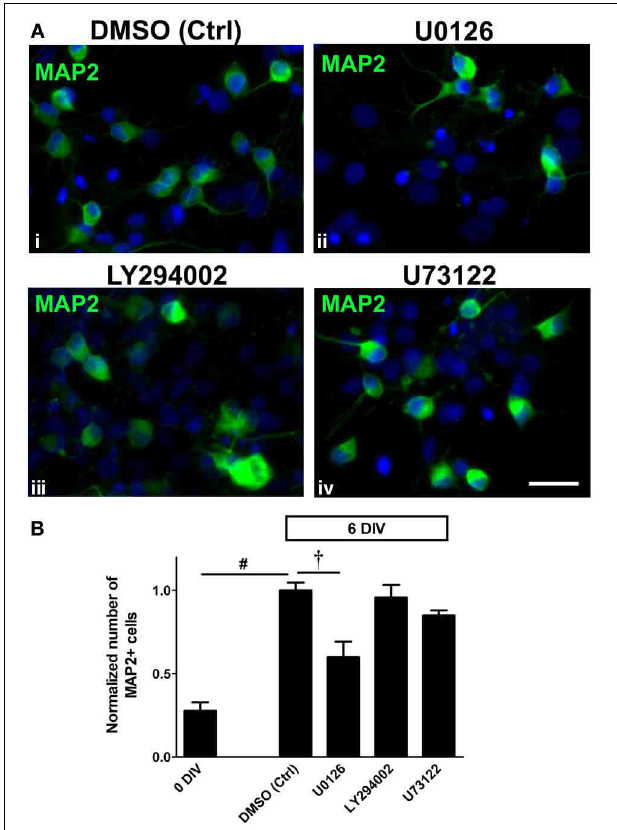
FIGURE 4 | Neuronal differentiation in adult spinal cord NSPC cultures is ERK1/2-dependent. (A) Immunostaining for MAP2 in adult spinal cord NSPC cultures after 6DIV in vehicle control (DMSO) (i), U0126 (10 μ M) (ii), LY294002 (10 μ M) (iii), and U73122 (2.5 μ M) (iv). Compared to the vehicle control (i), the number of MAP2 + cells was noticeably less when the cells were treated with the MEK inhibitor, U0126 (ii). Blue represents Hoechst-stained nuclei. Scale bar: 20 μ m. (B) Quantification of the normalized number of MAP2 + cells in adult spinal cord NSPC cultures (6DIV). By 6 days, there was a similar increase in MAP2 + cell number as shown in Figure 2 . Only U0126 (which inhibited ERK1/2 activation) significantly inhibited the increase of the number of MAP2 + cells after 6 days. LY294002 (10 μ M) and U73122 (2.5 μ M) had no significant effect on neuronal differentiation (10 random fields with a 40 × objective per coverslip were analyzed, n = 6 coverslips, except LY294002: n = 5 coverslips and U73122: n = 3 coverslips; † P < 0 . 001, # P ≤ 0 . 0001, One-Way ANOVA Bonferroni’s multiple comparison post-test). All values are normalized to the DMSO control in each